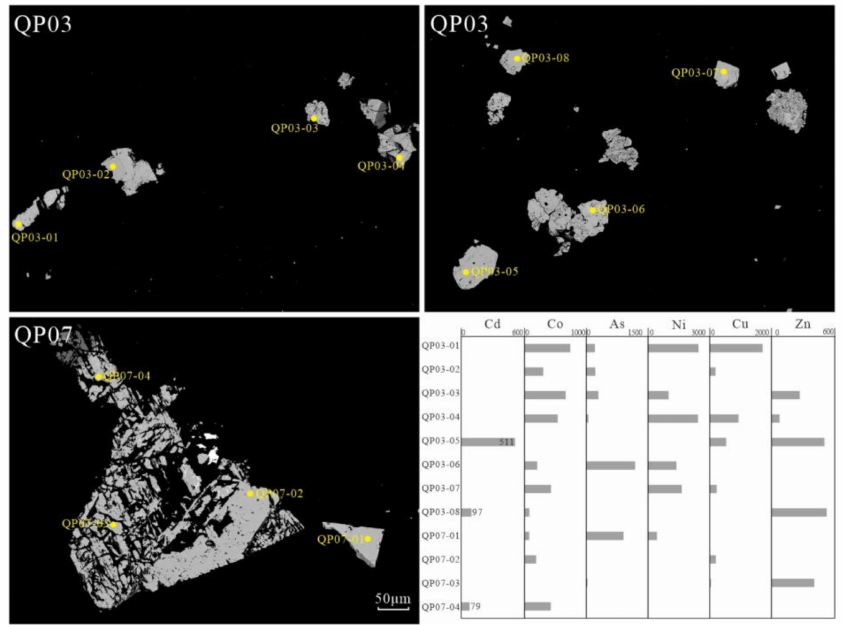
Figure 6. Element content in pyrite obtained determined on